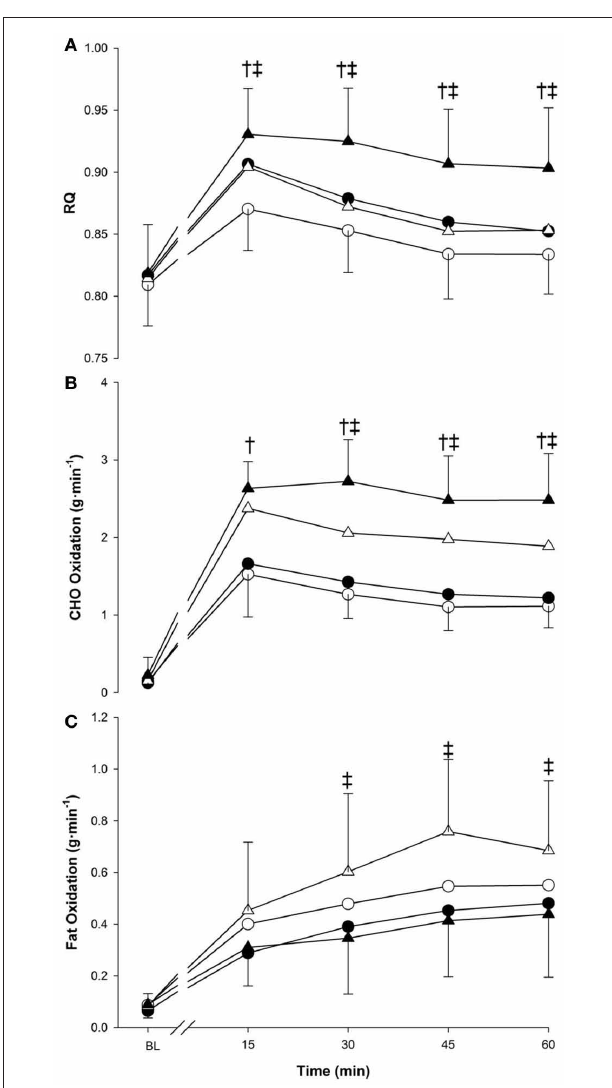
FIGURE 2 | Respiratory quotient (panel A), CHO oxidation (panel B) and fat oxidation (panel C) at baseline (BL) and during 60min of exercise during walking ( (cid:2) and • ) and running ( (cid:2) and (cid:2) ), in cold ( (cid:2) and (cid:2) ), and neutral ( • and (cid:2) ) ambient temperatures. Mean ( ± SD). † Significant difference between walking and running ( P < 0 . 05). ‡ Significant difference between cold and neutral ( P < 0 . 05).